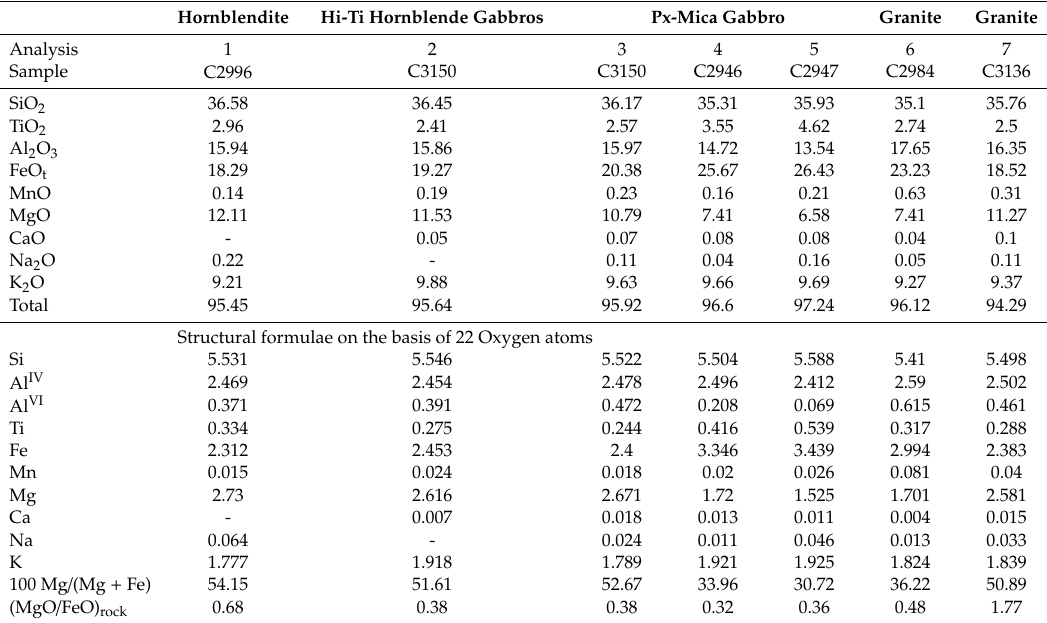
Table 4. Representative analyses of biotite by electron